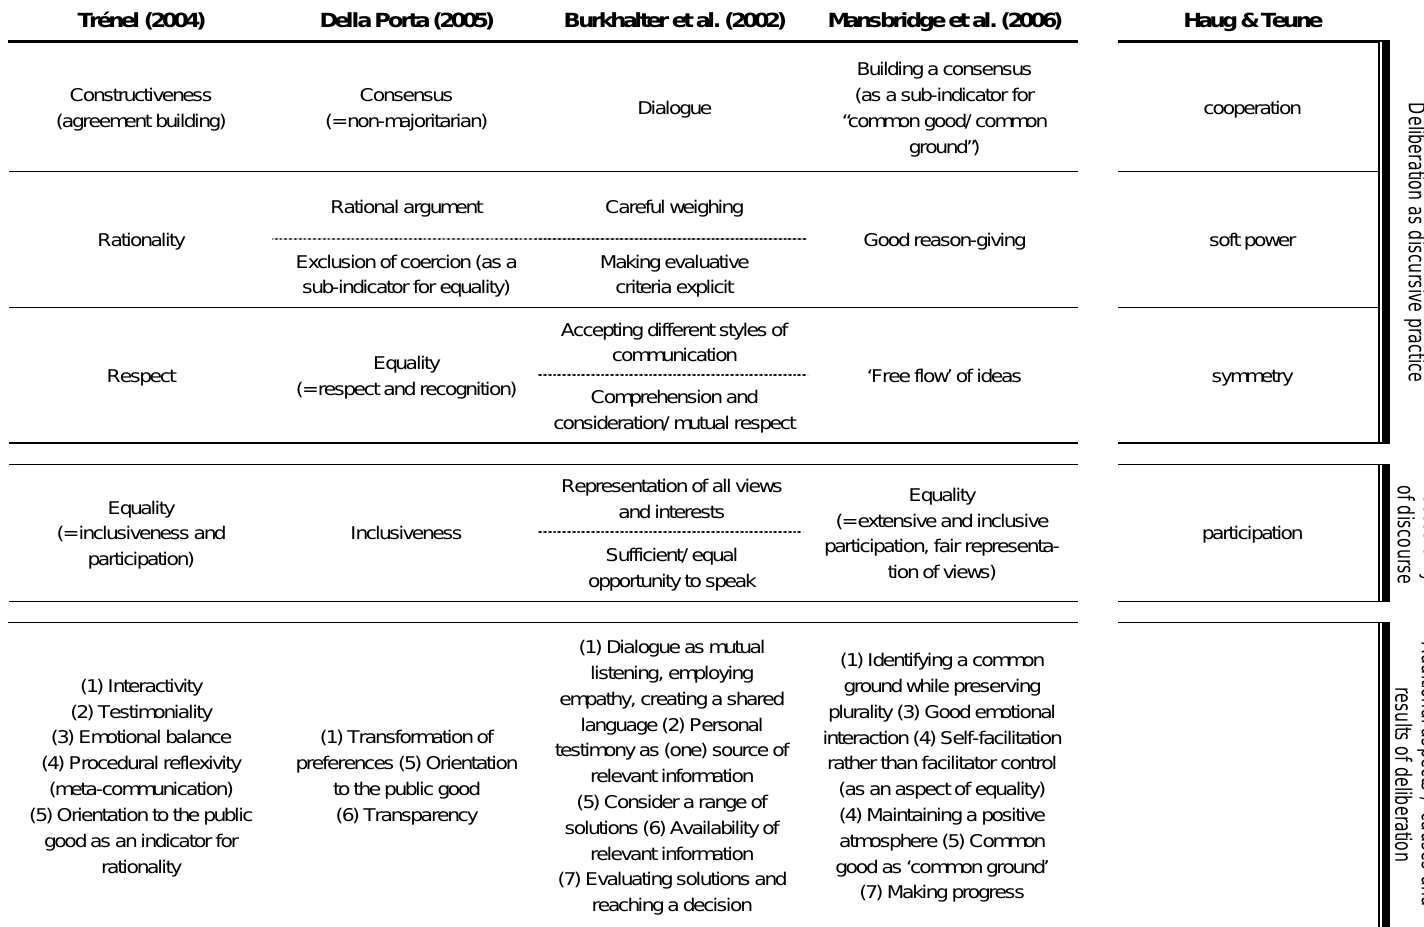
Table 1: Criteria for deliberation Trénel